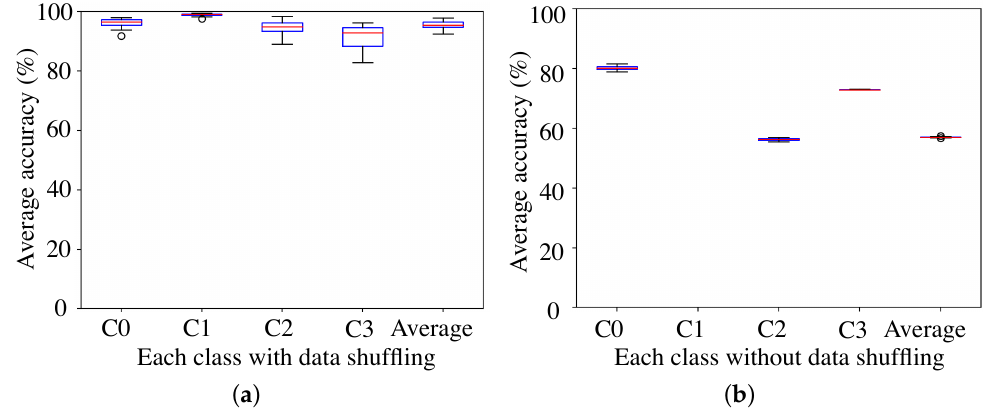
Figure 15. The effect of shuffling input data for training a GAN based model: ( a ) with shuffling and ( b ) without